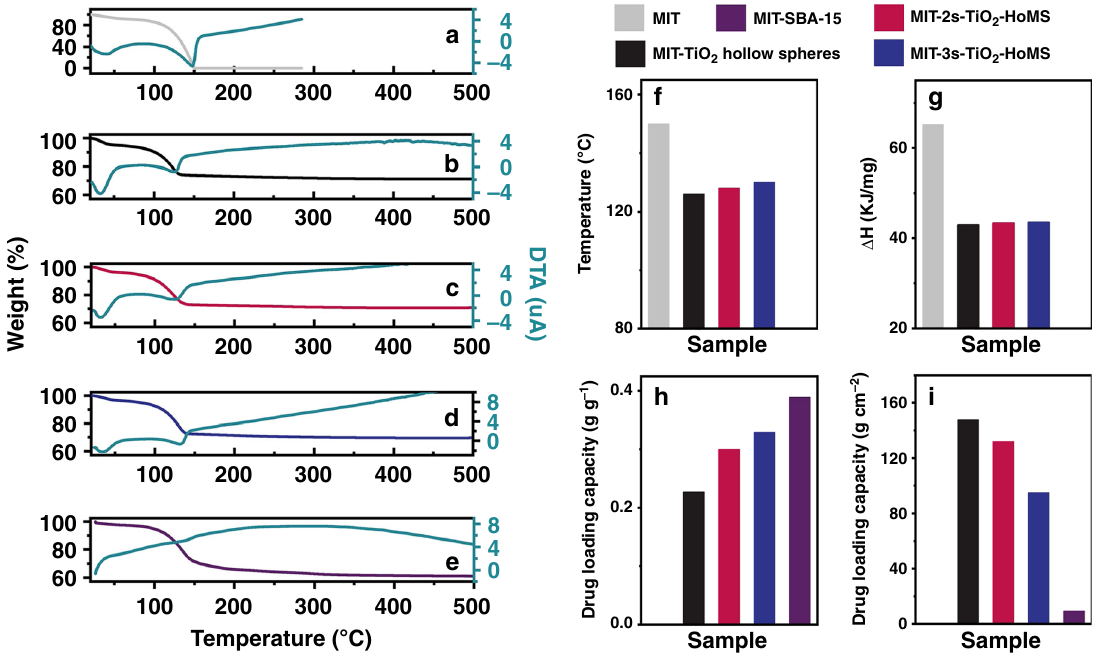
Fig. 3 Adsorption, desorption, and diffusion of MIT molecules in HoMS. TG – DTA of a MIT, b MIT – TiO 2 hollow spheres, c MIT-2s-TiO 2 – HoMS, d MIT-3s-TiO 2 – HoMS, e MIT-SBA-15. f Evaporation temperature and g relative value of endothermic heat for MIT release. MIT loading capacity after normalization to h weight and i surface area. Source data are provided as a Source Data fi